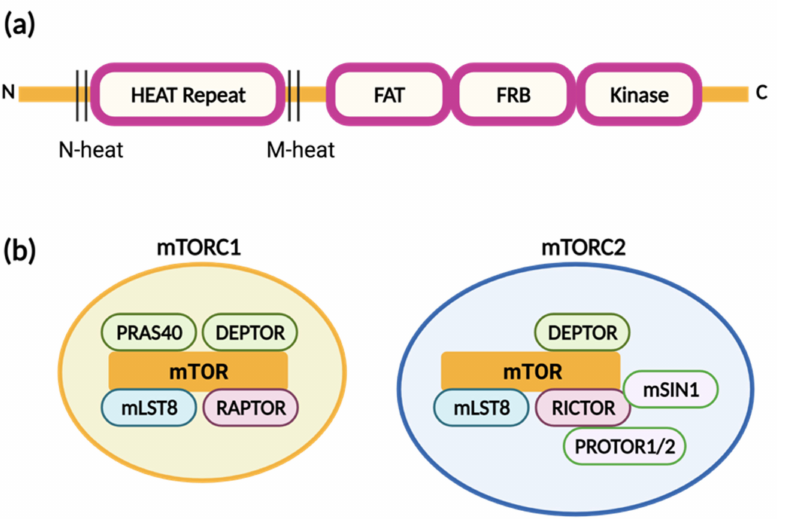
Figure 4. ( a ) Structures of mTOR1 and mTOR2 (created with BioRender.com). Each mTOR consists of HEAT repeats, FAT, FRB, and kinase domains. ( b ) mTOR complex 1 (mTORC1) is composed of mTOR, Raptor, mLST8, Deptor, and PRAS40, whereas mTORC2 includes mTOR, Rictor, mLST8, Deptor, mSin1, and Protor